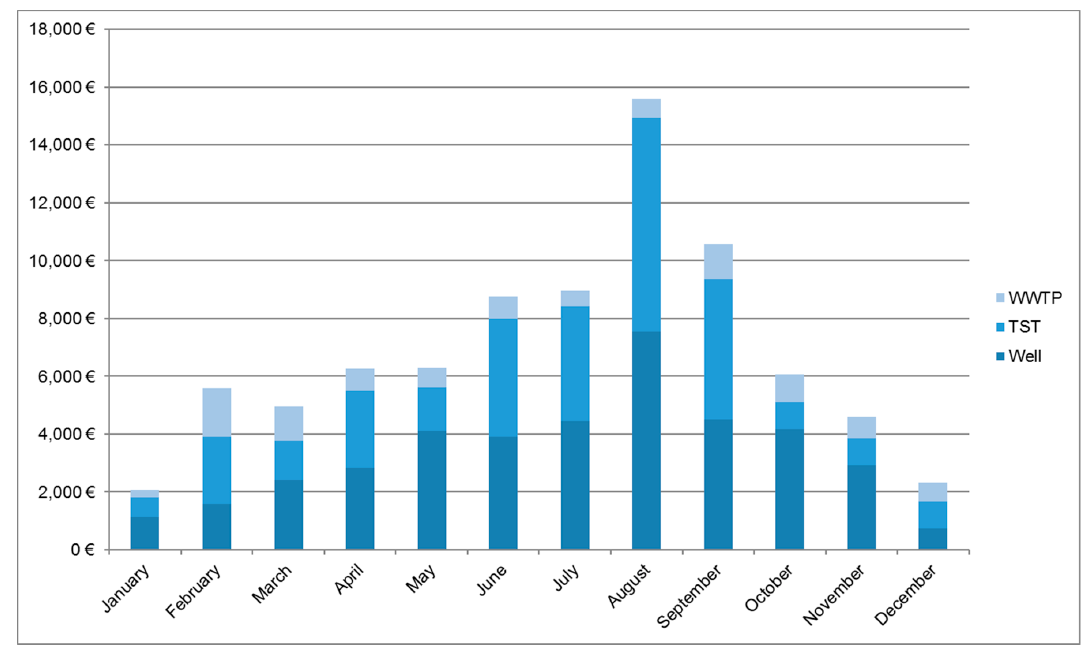
Figure 7. Total financial expense. 2016.